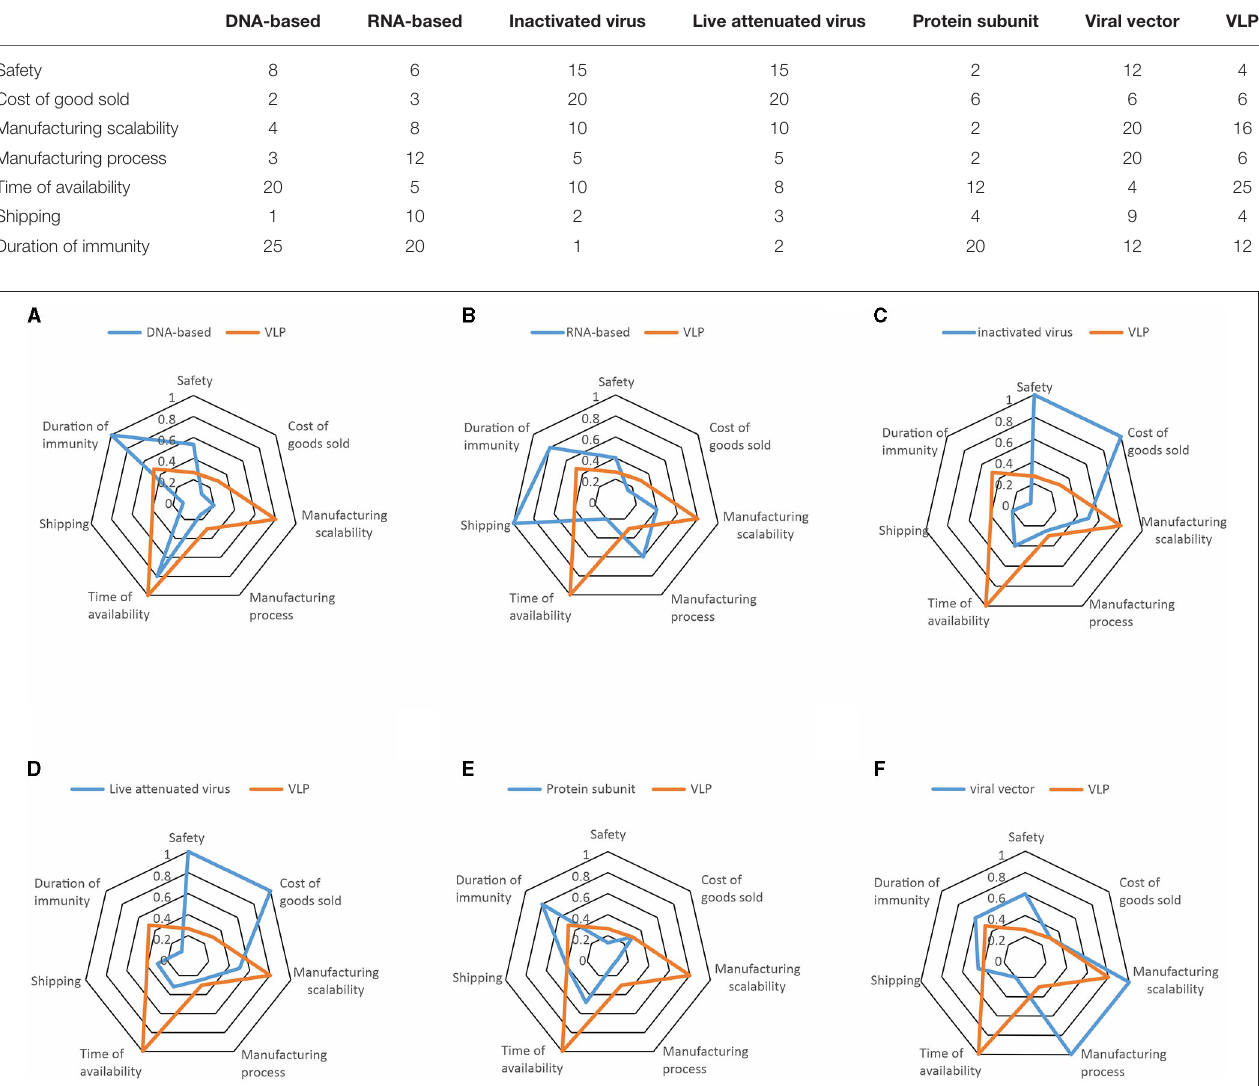
FIGURE 1 | The radar charts of the seven different vaccine technologies illustrating the major risks estimated by risk score, expressed in percentage. Risks represented are safety, cost of goods sold, manufacturing scalability, manufacturing process, time of availability, shipping, and duration of immunity. Each technology is represented in blue while being compared to virus-like particle (VLP) in orange. Risk associated to (A) DNA-Based, (B) RNA-based, (C) inactivated virus, (D) live attenuated virus, (E) protein subunit, and (F) viral vector vaccines are presented. The most important risks point toward 100, while less important risks point toward 0.